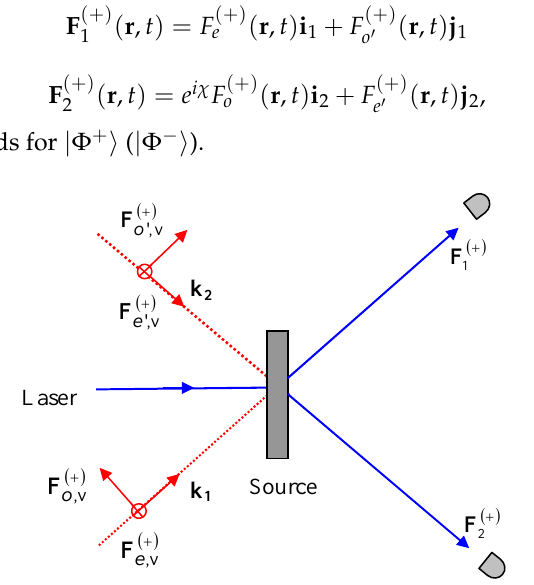
Figure 1. Polarisation entanglement arises as a consequence of the coupling of the laser and four sets of zeropoint modes, two for each input